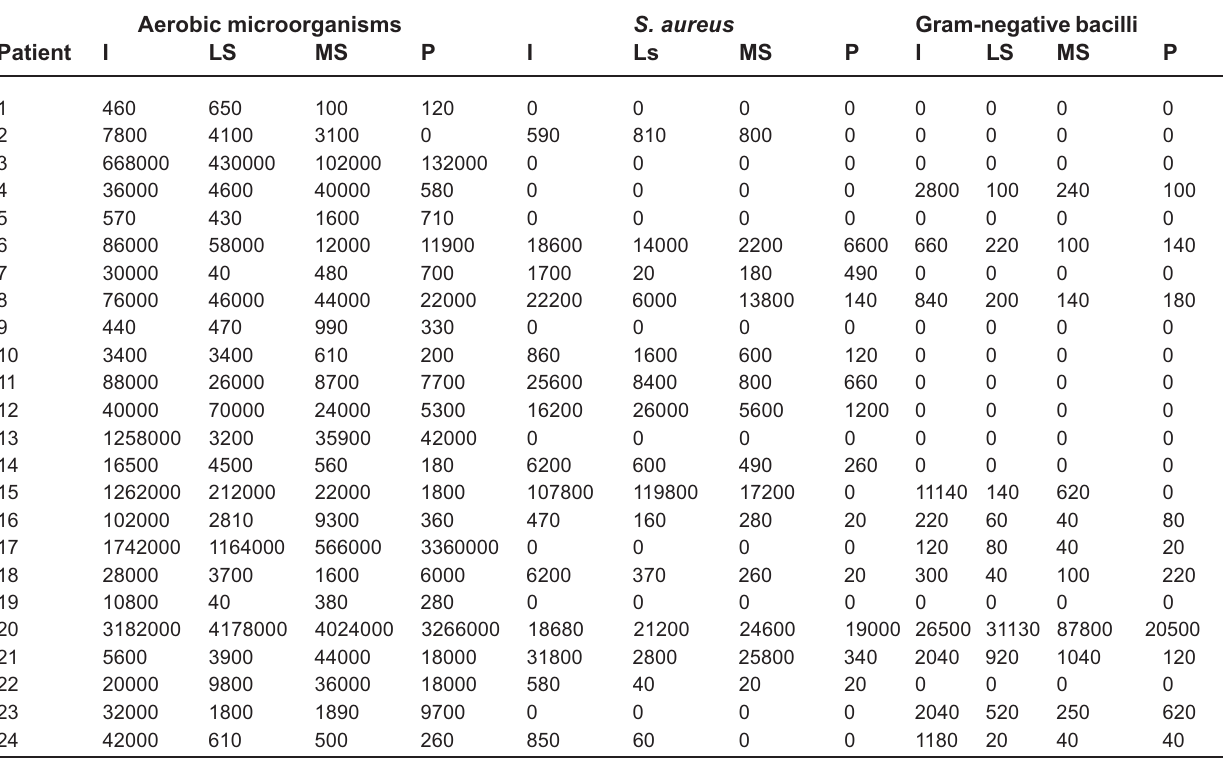
TABLE 2- Cfu counting for aerobic microorganisms, S. aureus and gram negative bacilli in the anophthalmic